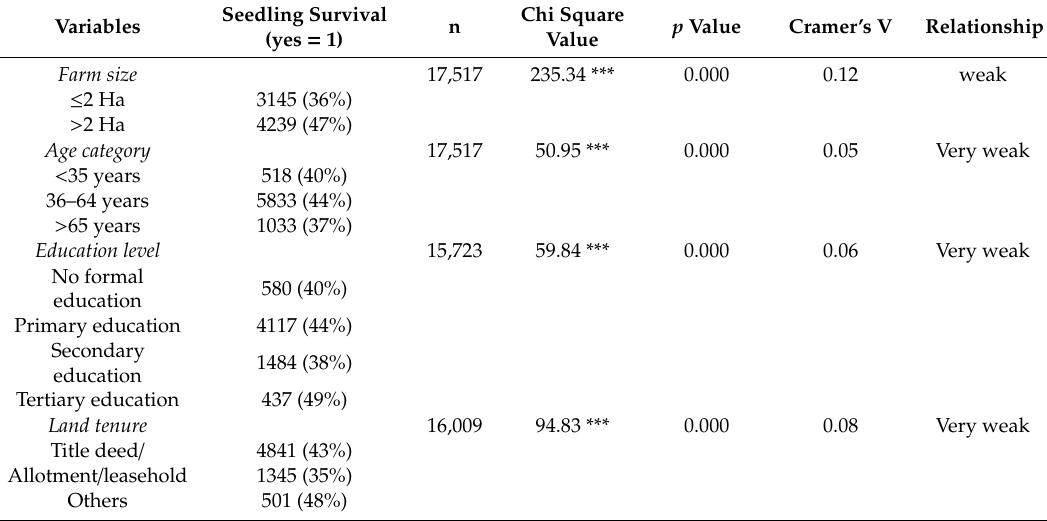
Figure 3. Performance of tree species against di ff erent combination of options that were tested in Kenya. Combinations presented here are described in Table 6. Table 7. Results of the chi square test for a relationship between seedling survival and socioeconomic characteristics of a household and biophysical characteristics of the farm in Kenya. Significance levels: 1% ‘***’ 5%